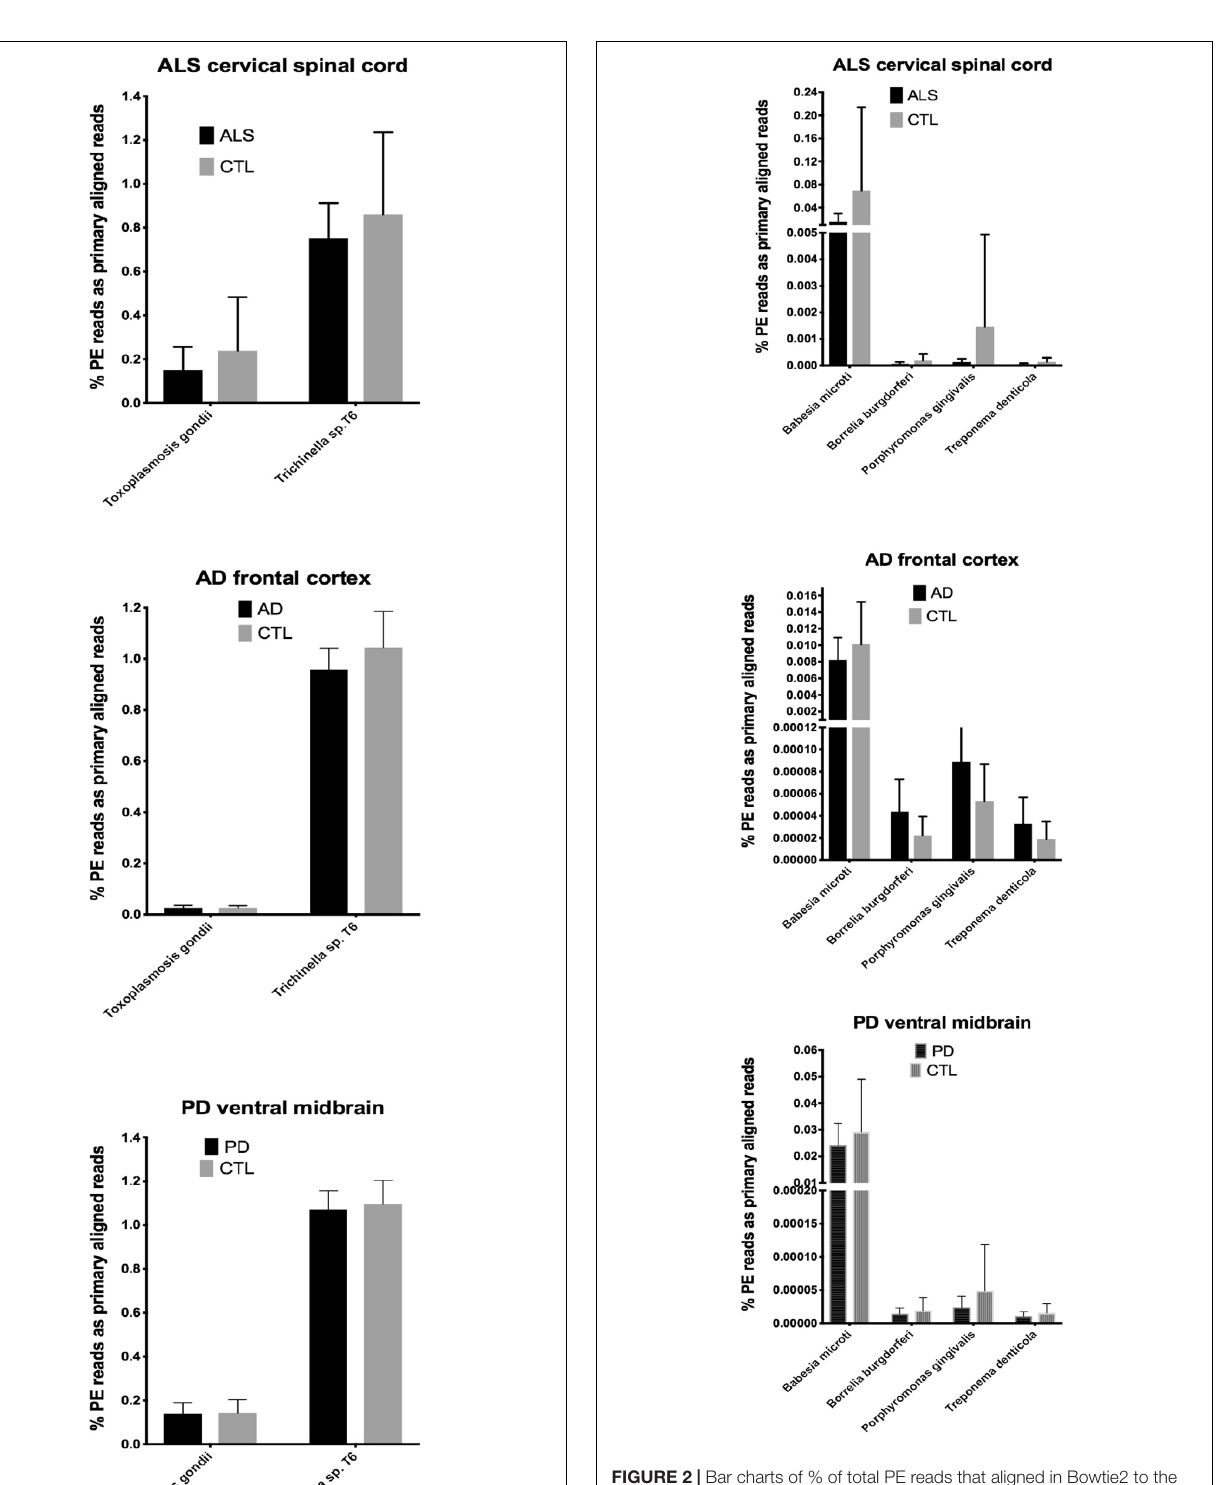
Figure 5 (PD) show the results of our RNA seq studies of gene expressions associated with (a) homeostatic microglial genes (top graph in each Figure); (b) expression of Stage 1 DAM